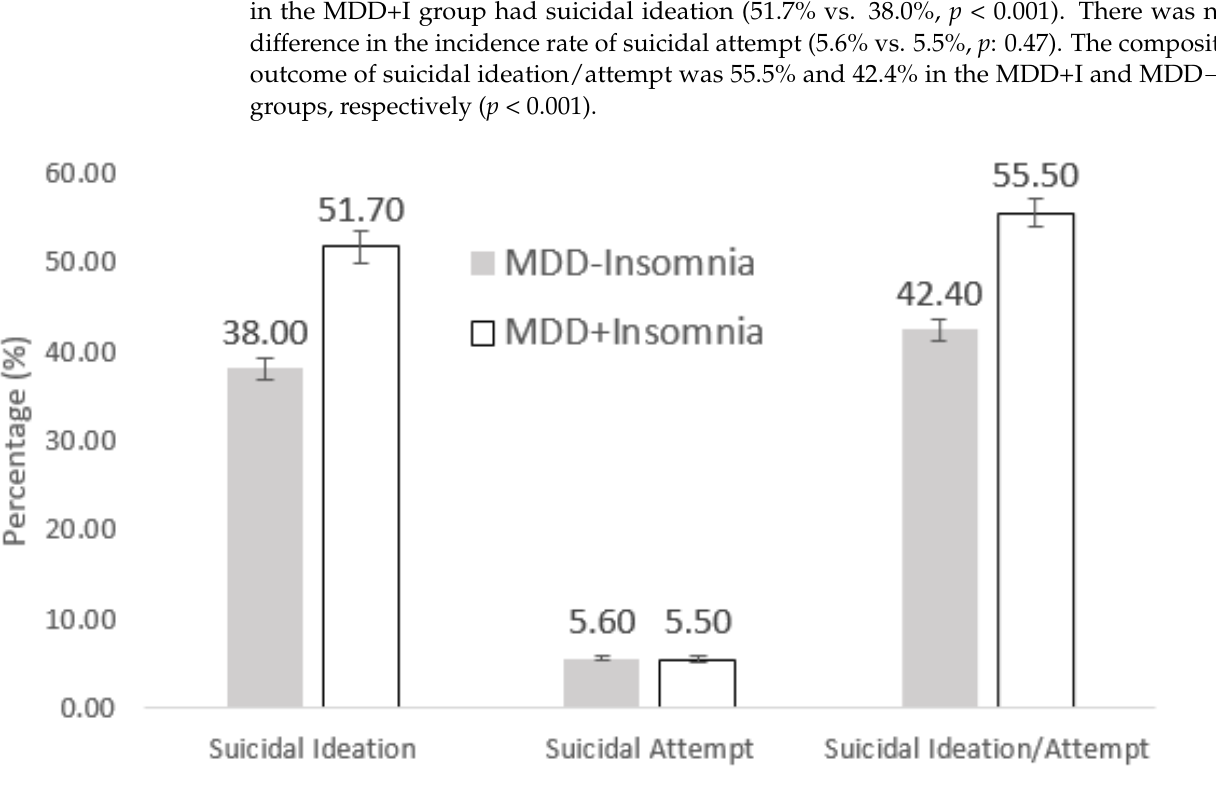
Figure 1. Rate of suicidality between two groups.